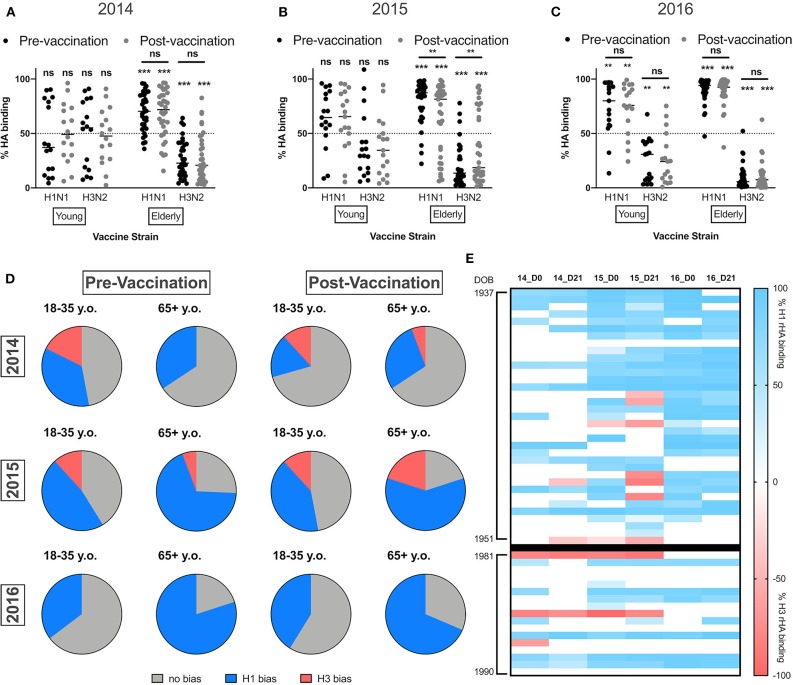
Elderly subjects have significantly immunodominant response to the H1N1 vaccine component. (A–C) Percentage of IgA HA-binding to the H1N1 or the H3N2 vaccine strain calculated as described in the M&M section in young adults and elderly subjects vaccinated in 2014 (A) 2015 (B) or 2016 (C). (D) Frequency of young adults and elderly subjects with a significant immunodominant IgA response toward the H1N1 or H3N2 vaccine strains pre- and post-vaccination. (E) Heatmap for the percentage of immunodominant response to each IAV vaccine strain from 2014 to 2016. Donors are represented as rows organized by date of birth (DOB). Blue indicates significant immunodominance of the H1N1 vaccine strain, red represents significant immunodominance of the H3N2 vaccine strain, and white shows balanced responses. **p < 0.01, ***p < 0.001.